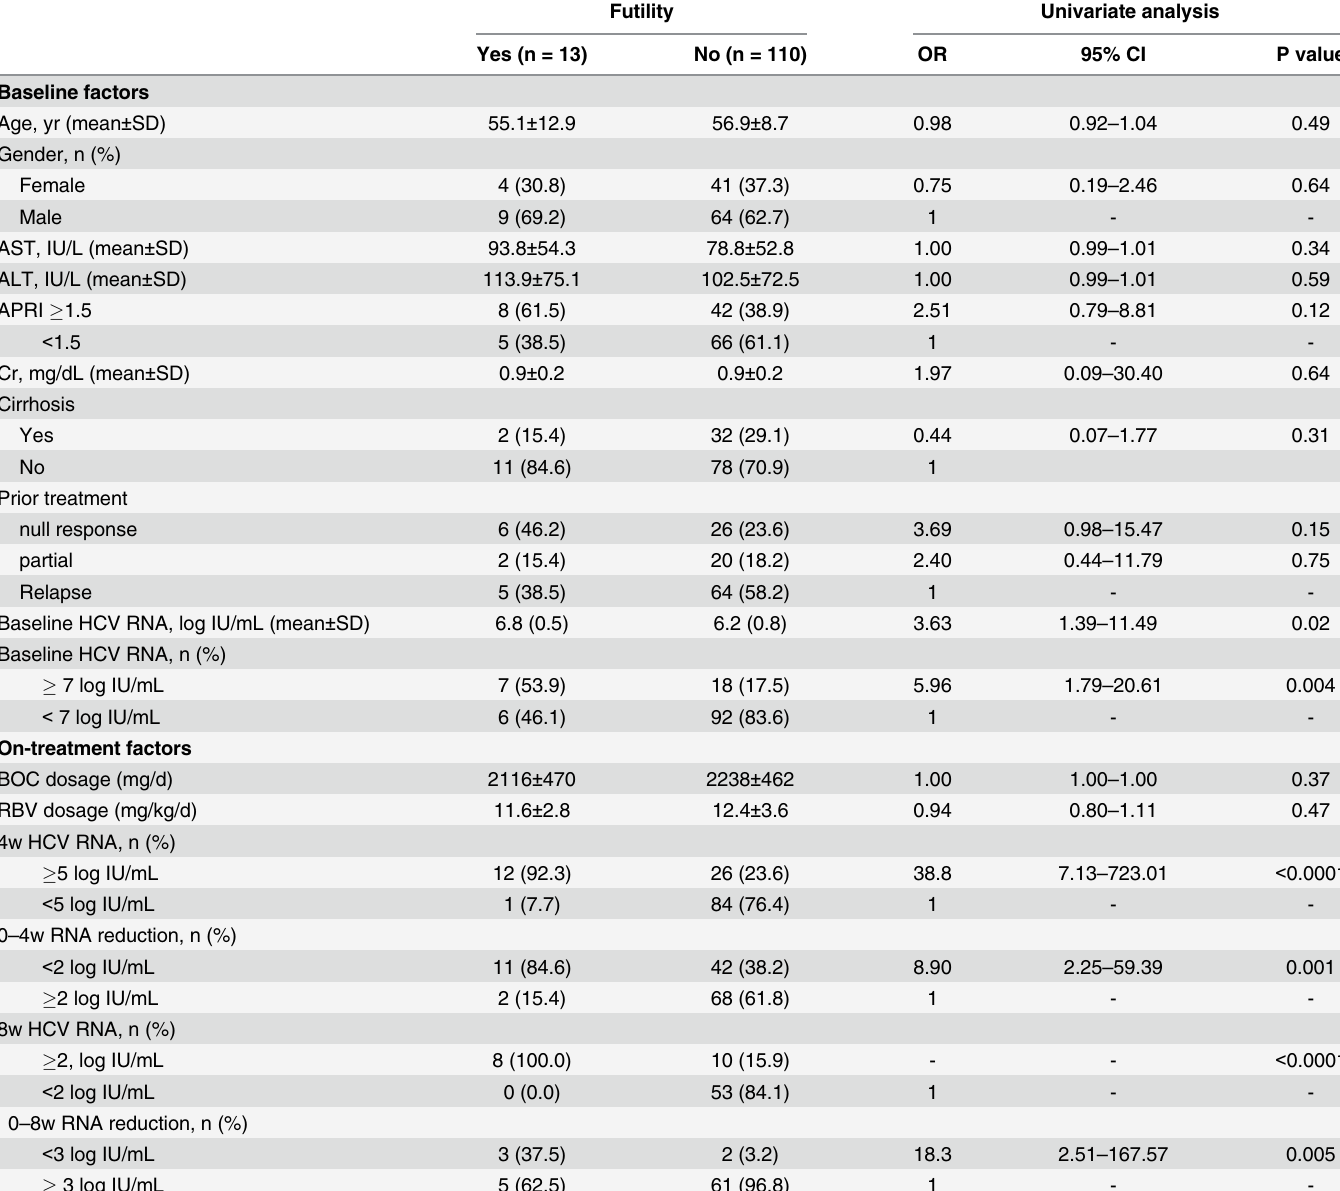
Table 5. Factors associated with week 12 and week 24 futilities. Abbreviations: BOC, Boceprevir; RBV, ribavirin; AST, aspartate aminotransferase; ALT, alanine aminotransferase; Ccr, Creatinine clearance rate; APRI, aspartate aminotransferase-to-platelet ratio index; OR, odds ratio; CI, confidence intervals. Futility Univariate